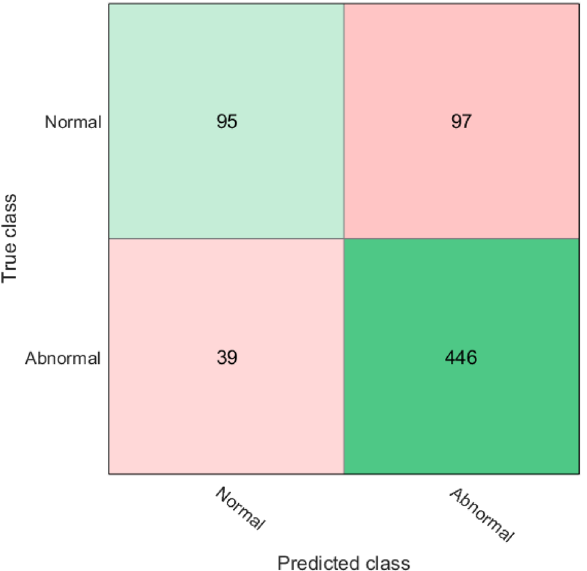
Figure 4. The true versus predicted visual field damage obtained using the ensembles machine learning bagged trees model.